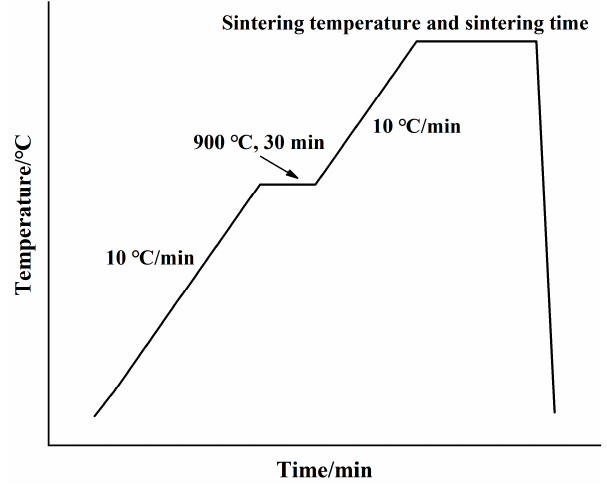
Figure 2. Sintering system of clinker.